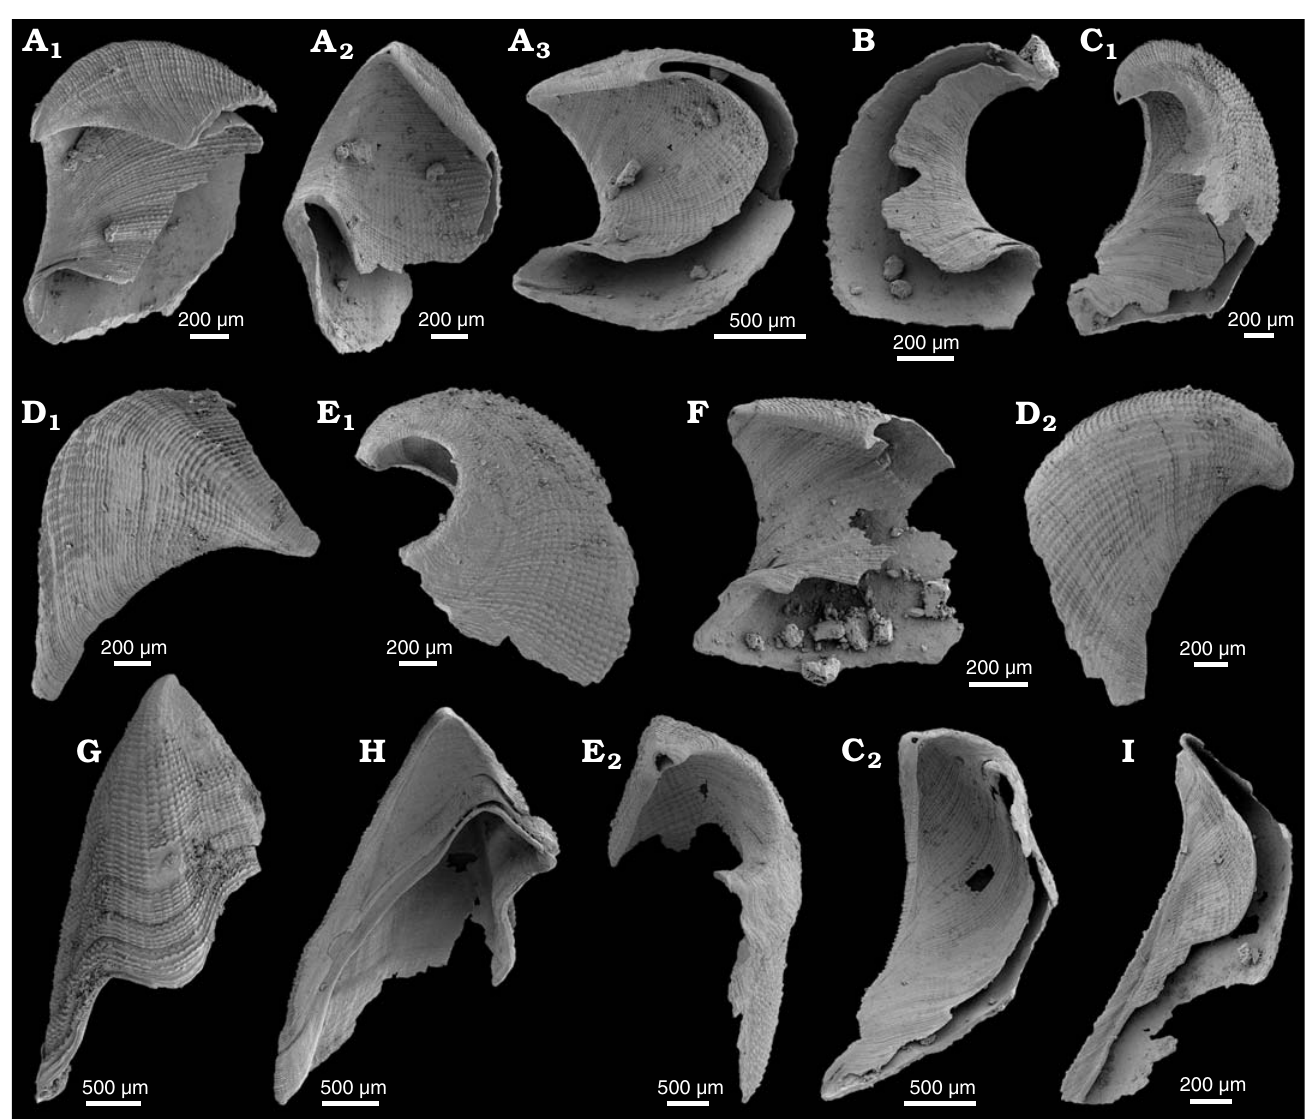
Fig. 18. C2a sclerites of the camenellan tommotiid Dailyatia decobruta Betts sp. nov. from the lower Cambrian White Point Conglomerate, Kangaroo Island, South Australia. A . SAM P57360 in ventral view; A 1 –A 3 , multiple views showing strong convexity and compression of sclerite. B . SAM P57361 in lateral view. C . SAM P573762 in oblique ventral view (C 1 ); C 2 , slightly rotated view showing extreme compression of sclerite. D . SAM P57363 in dorsal view; D 1 , D 2 , different views showing strong curvature of sclerite and weak plication on dorsal surface. E . SAM P57364 in dorsal view, E 1 , E 2 , multiple views showing strong curvature (including weak torsion). F . SAM P57365 in ventral view. G . SAM P57359, holotype in dorsal view. H . SAM P57366 in ventral view. I . SAM P57367 in oblique ventral